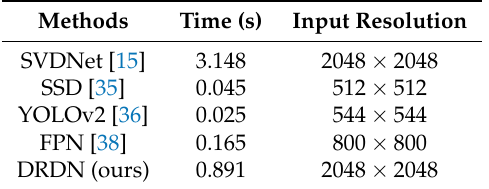
Figure 16. Ship detection results in different backgrounds. Each image has a size of 2048 × 2048 pixels. Table 6. Processing time of different detection